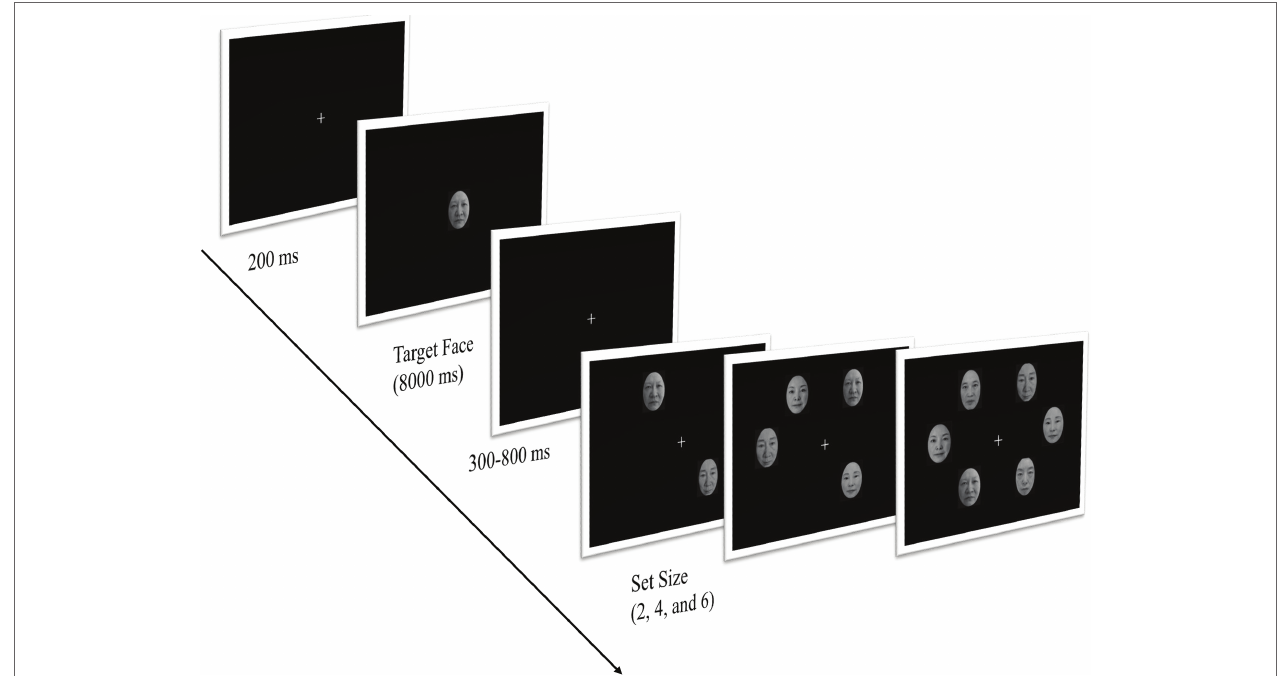
FIGURE 1 | The procedure of Experiment